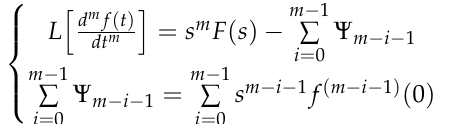
Figure 3. Control block diagram of the two-inertia elastic system.